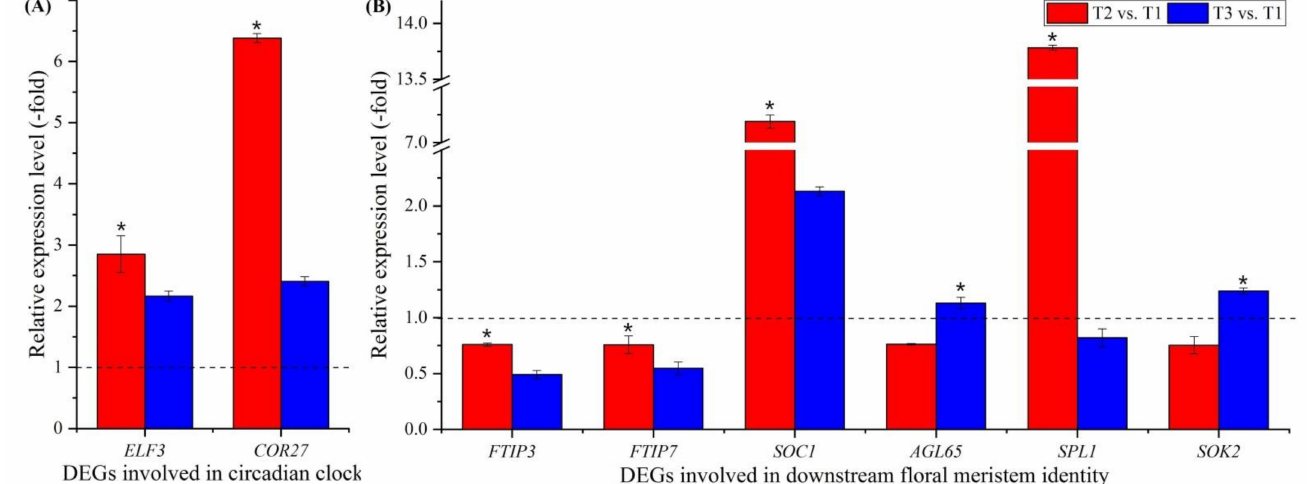
Figure 9. Expression levels of 2 genes involved in the circadian clock ( A ), and 6 genes involved in downstream floral meristem identity at T2 vs. T1 and T3 vs. T1 ( B ). Here and below, “*” represents a significant difference at the p < 0.05 level between T2 vs. T1 and T3 vs. T1 for the same gene; the use of different letters represents a significant difference ( p < 0.05) at different temperature